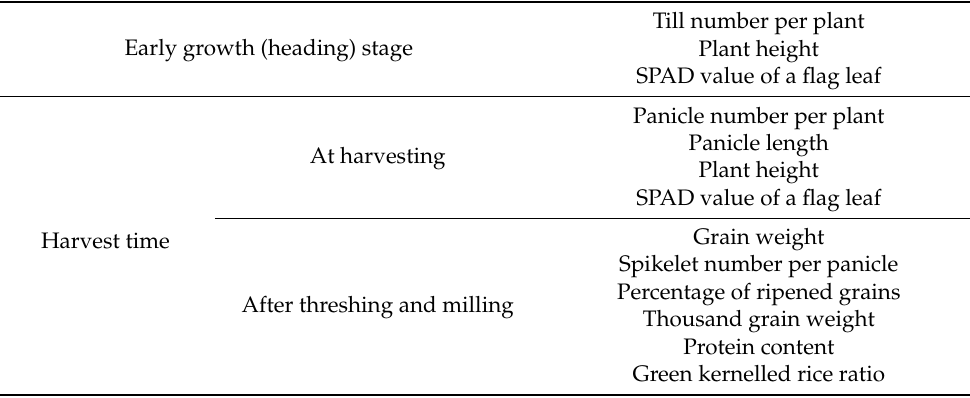
Table 1. Description of measurement items.